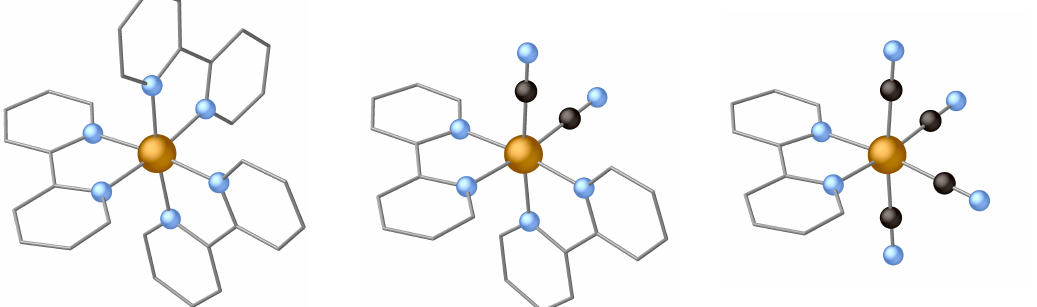
Figure 4. From left to right: [Fe(bpy) 3 ] 2 + , [Fe(bpy) 2 (CN) 2 ] and [Fe(bpy)(CN) 4 ] 2 − . Large gold spheres represents Fe, blue spheres N, black spheres C and the carbon skeleton of the bipyridine ligand is represented by the grey cylinders. Hydrogens are omitted for